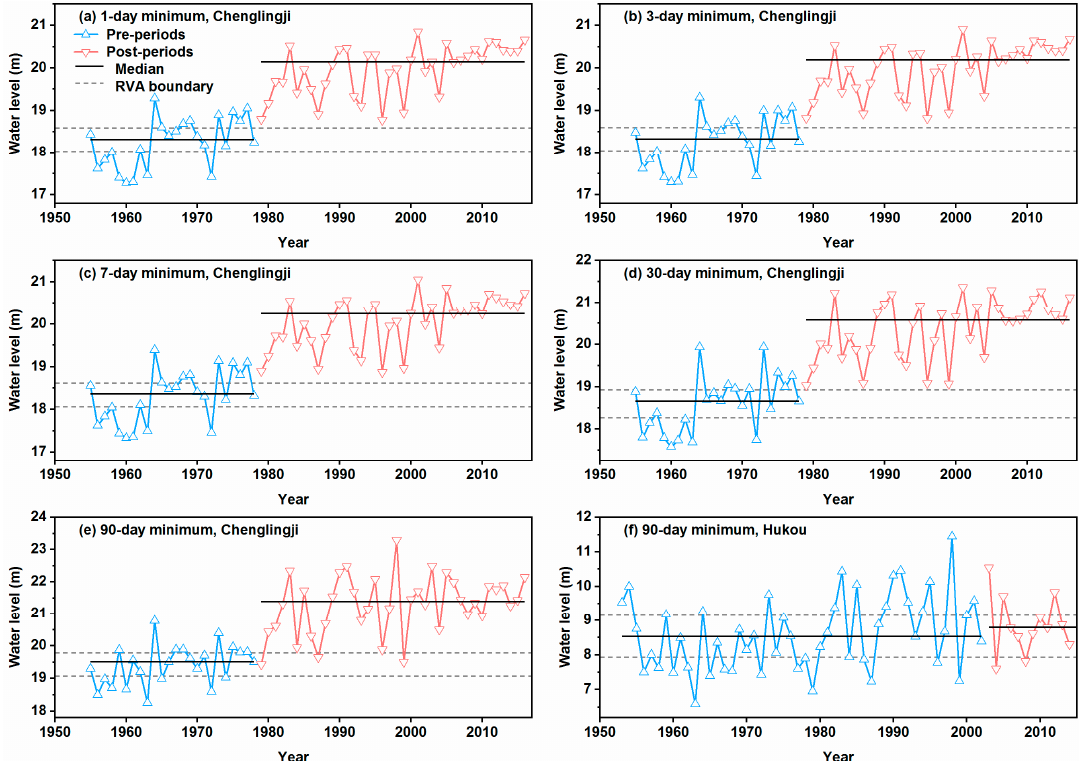
Figure 3. Variations in the highly and severely altered annual minimum water level at Chenglingji and Hukou. ( a ) Annual 1-day minimum water level at Chenglingji, ( b ) Annual 3-day minimum water level at Chenglingji, ( c ) Annual 7-day minimum water level at Chenglingji, ( d ) Annual 30-day minimum water level at Chenglingji, ( e ) Annual 90-day minimum water level at Chenglingji, ( f ) Annual 90-day minimum water level at Hukou.